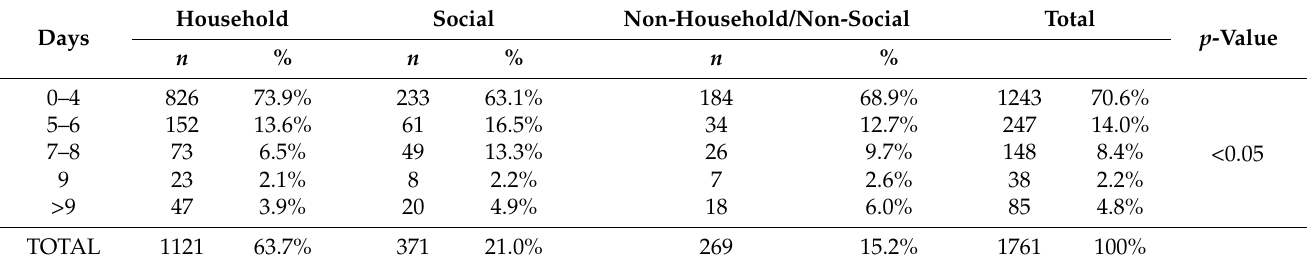
Table 3. Incubation period (expressed in days) among secondary cases by the setting of exposure.